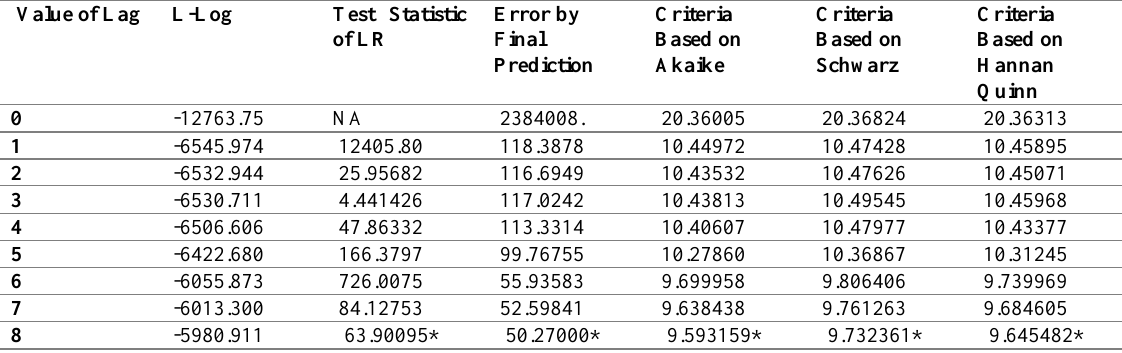
Table 6: Result of Optimal Lag Selection of Public Banks